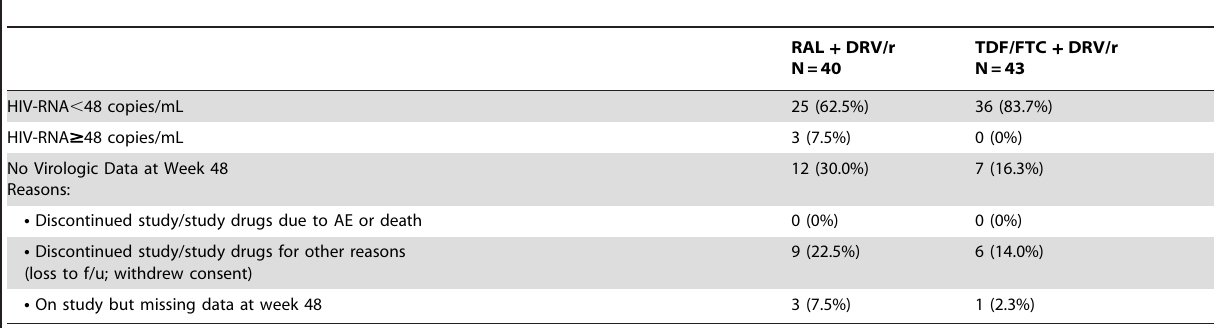
Table 3. Virologic Outcome at Week 48 - FDA Snapshot Analysis.